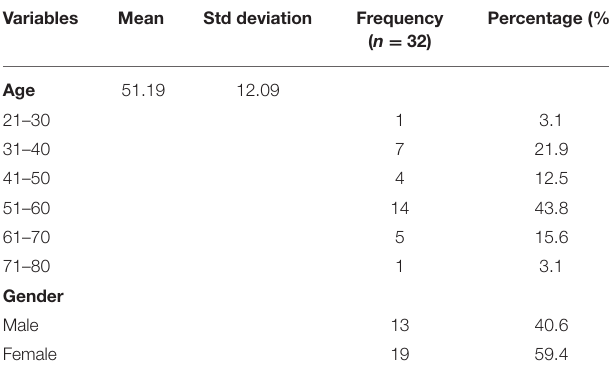
TABLE 1 | Data of socio-demographic characteristics of